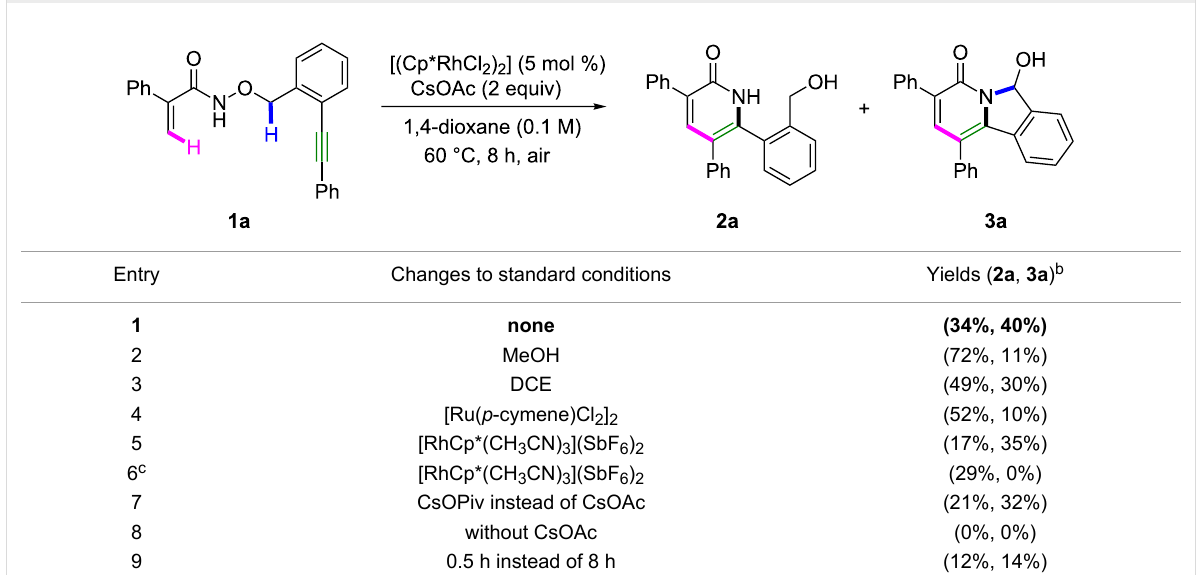
Table 1: Optimization of the reaction conditions.